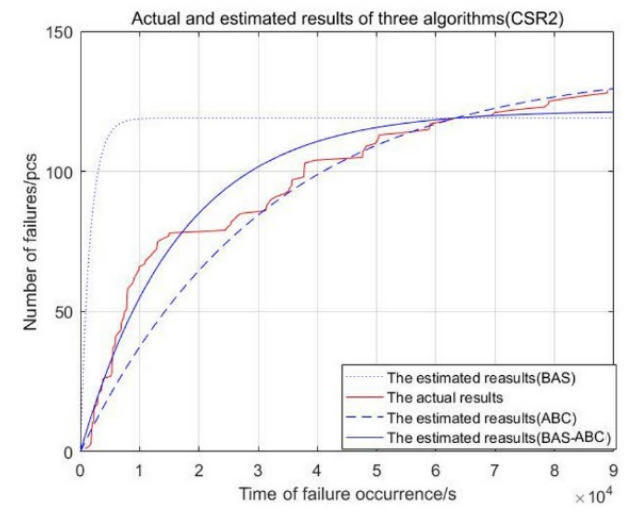
Figure 5. Actual and estimated time of failure occurrence of three algorithms (CSR1).